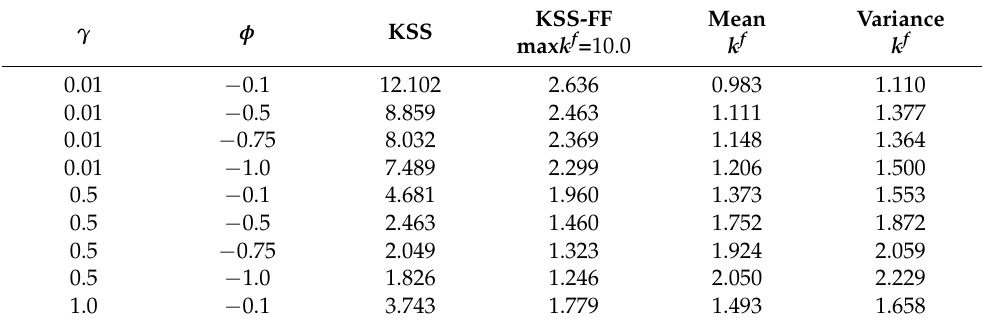
Table 1. Simulation analysis for approximating the Taylor residuals with the Fourier